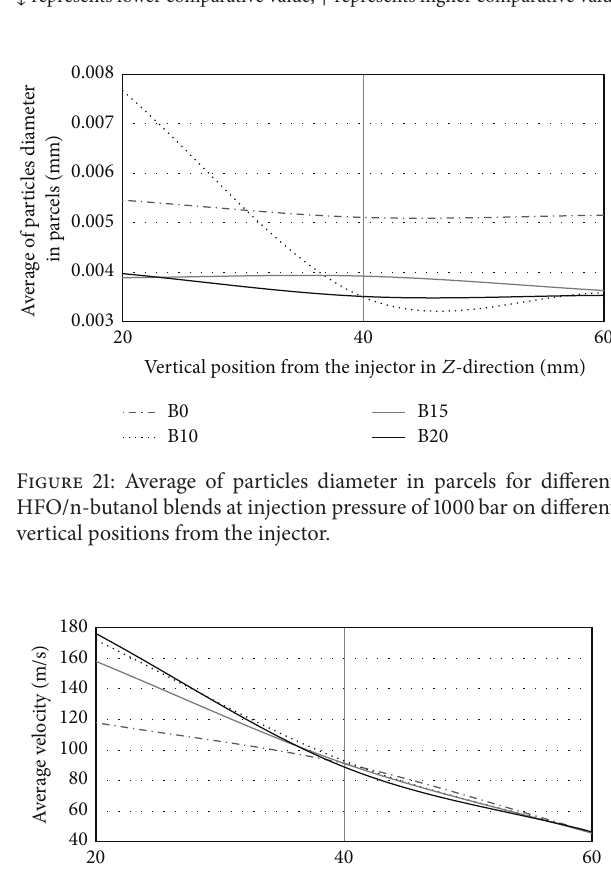
↓ represents lower comparative value; ↑ represents higher comparative value.